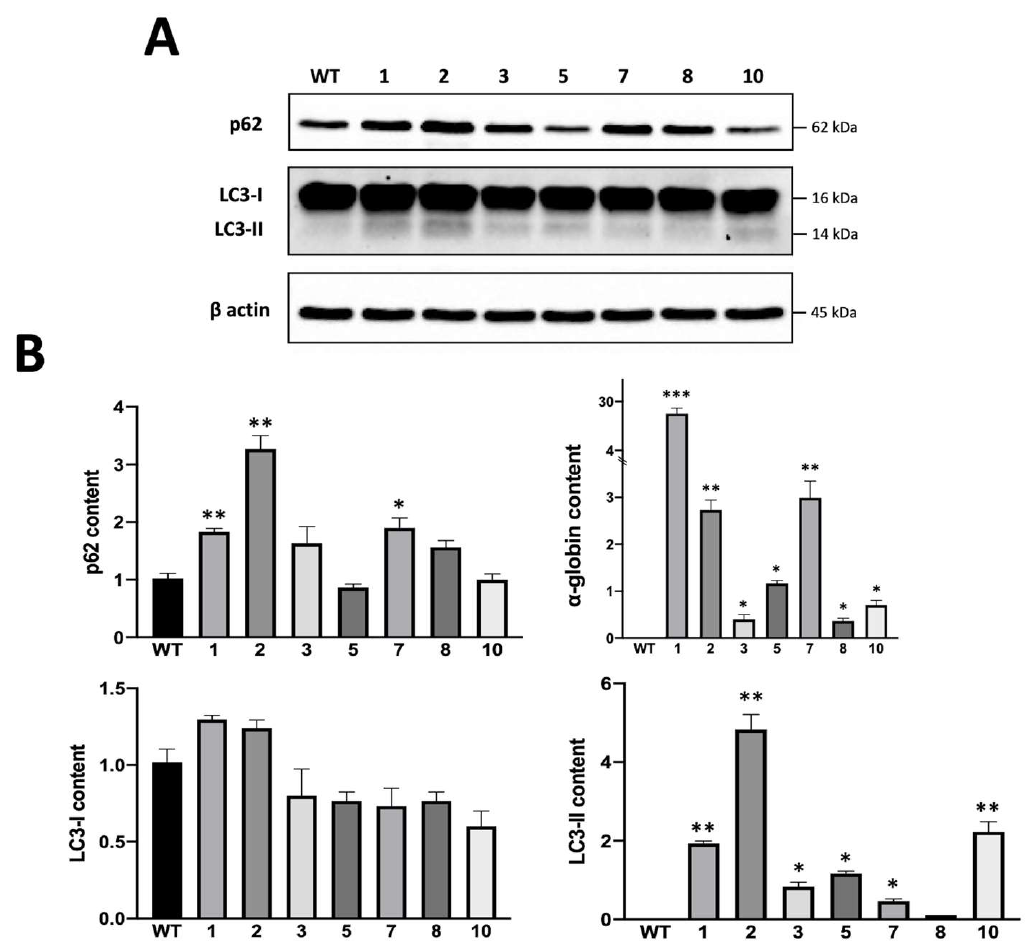
Figure 6. Representative Western blotting experiment showing p62 and LC3-I/II levels in K562 wild-type cells compared to those in obtained clones hyper expressing α -globin protein ( A ). Western blotting summary of p62 and LC3-I/II protein levels in K562 and obtained clones hyper-expressing α -globin. Soluble α -globin protein content is reported in the upper-right part of panel B to show the correlation between p62 and α -globin production in tested clones (mean ± SD; N = 3) ( B ). p < 0.05 (*), p < 0.01 (**), p < 0.001 (***).